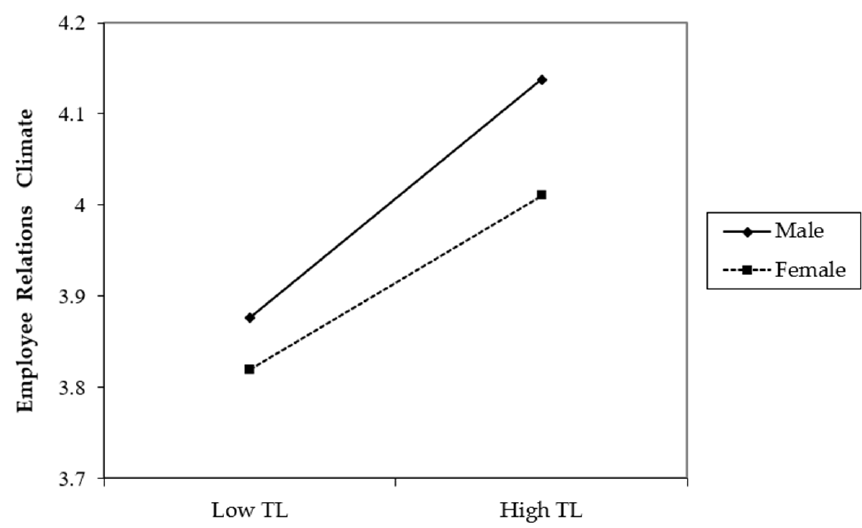
Figure 2. The influence of transformational leadership on employee relations climate under different subordinate genders.